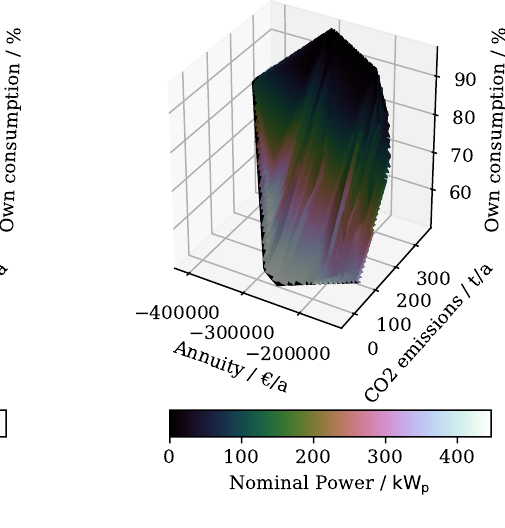
Figure 4. Presentation of exemplary optimal sizing results generated by the described methodology. It shows the Pareto front between the three key performance indicators (KPIs) (Section 4). Color-coded is the corresponding plant size, shown here as an example for combined heat and power (CHP) ( a ) and PV ( b ). Here it is shown for the CHP that a small to medium plant size is almost universally optimal, whereas for photovoltaics (PV) there is a high dependency on own consumption and CO 2